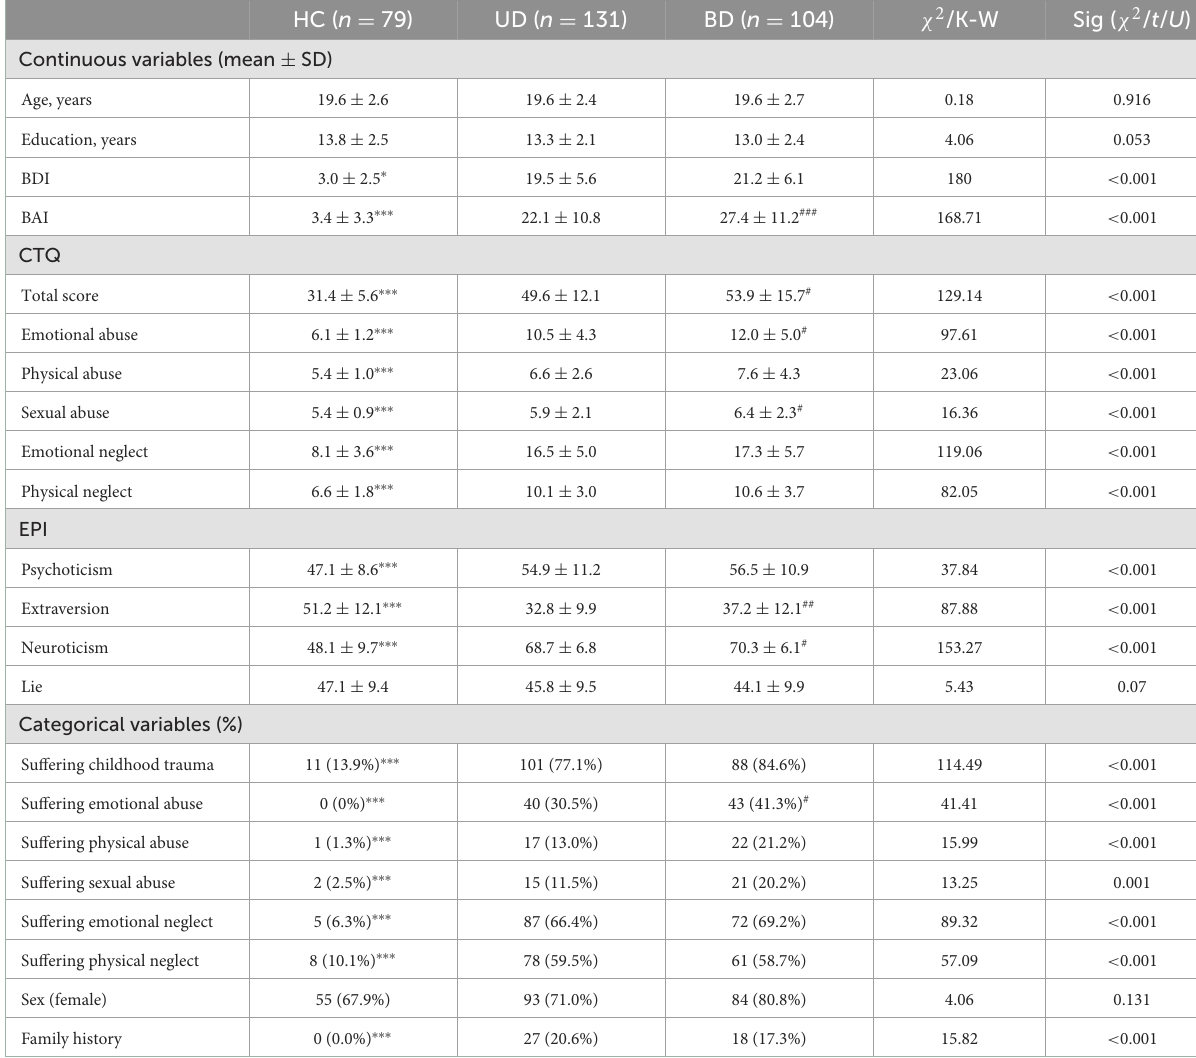
TABLE 1 Clinical and demographic characteristics and questionnaire measurement results of healthy controls and mood disorder patients (UD and BD). HC ( n = 79) UD ( n = 131) BD ( n = 104) χ 2 /K-W Sig ( χ 2 / t / U